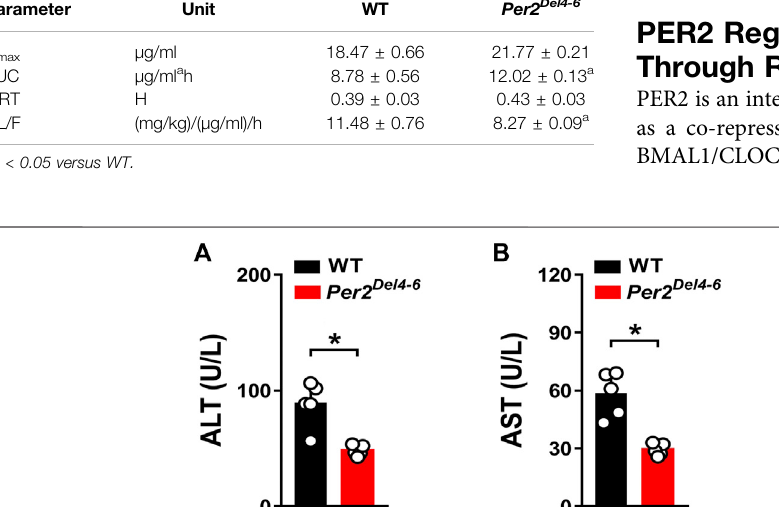
Frontiers in Pharmacology |